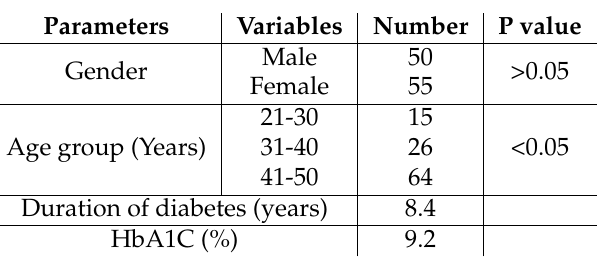
Table 1. Baseline characteristics